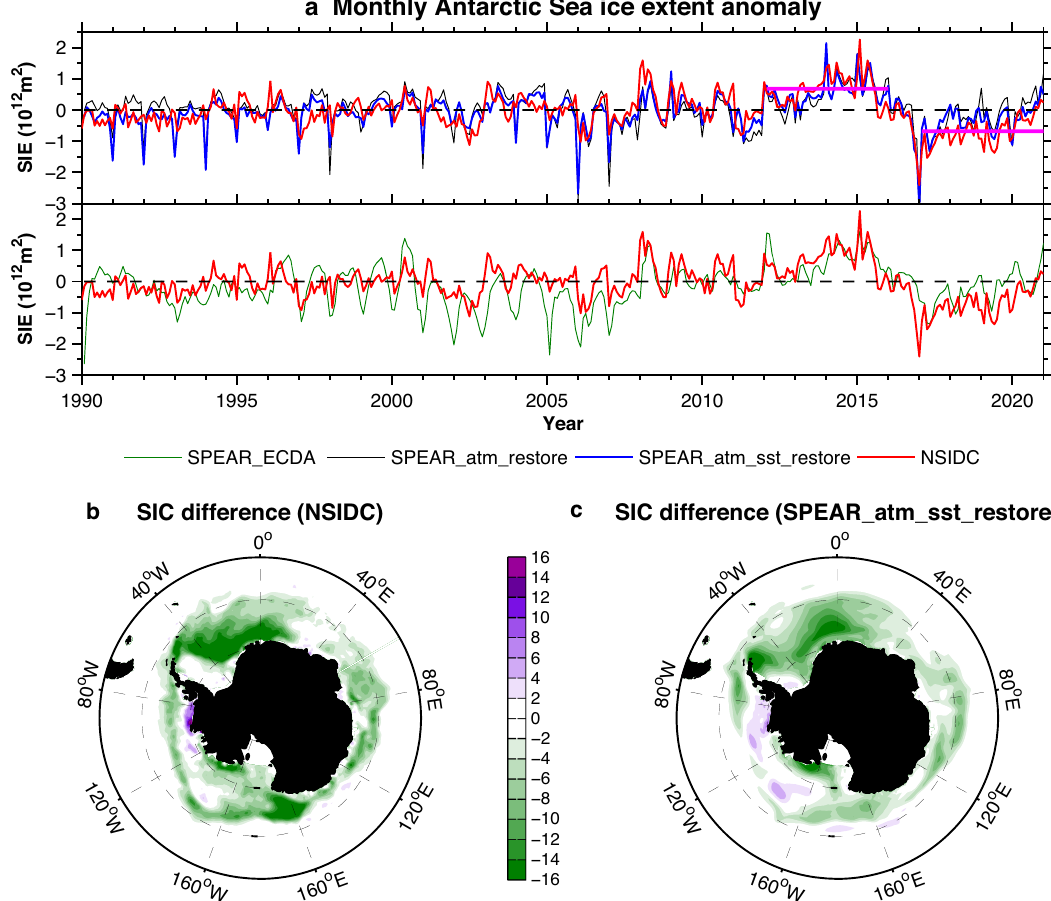
Fig. 1 Variability in Antarctic Sea ice extent (SIE) derived from observations and SPEAR model simulations. a Monthly mean SIE anomaly since 1990 with respect to the 1990 – 2020 climatology in SPEAR_ECDA (green line), SPEAR_atm_restore (black line), SPEAR_atm_sst_restore (blue line), and National Snow and Ice Data Center (NSIDC) observation (red line). Magenta lines are the time averages of SIE anomalies over the time period 2012 – 2015 and 2017 – 2020 in NSIDC. b Sea ice concentration (SIC) difference between time period 2017 – 2020 and 2012 – 2015 in NSIDC. c Same as ( b ) but in SPEAR_atm_sst_restore. Units are 10 12 m 2 for SIE and % for